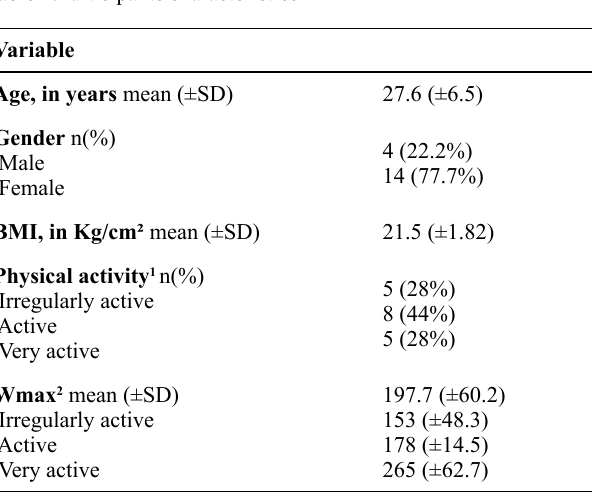
Figure 1.Experimental course. In session 1, subjects were submitted to maximal incremental exercise test to find out their maximal tolerated power (Wmax). In sessions 2,3 and 4, the effect of different exercise protocols on motor cortex excitability, as monitored via motor evoked potential (MEP – 20 stimulus) elicited by single pulse transcranial magnetic stimulation (TMS), was explored. Specifically, high (10min at 75% Wmax); moderate (15min at 60% Wmax) and low intensity (30 min at 45% Wmax) were compared with control session (session 5) with subjects at rest. The excitability was monitored every 5 min for one quarter of an hour (T0, T5, T10 and T15) after the end of exercise/rest. RPE - rating perception effort, HR - heart rate, MEP - motor evoked potential. Table 1.Participants characteristics